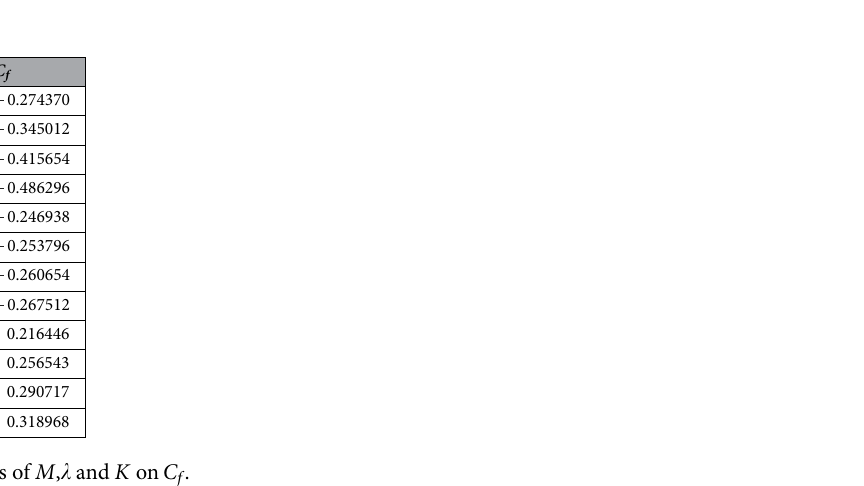
Table 3. Influences of M , (cid:31) and K on C f